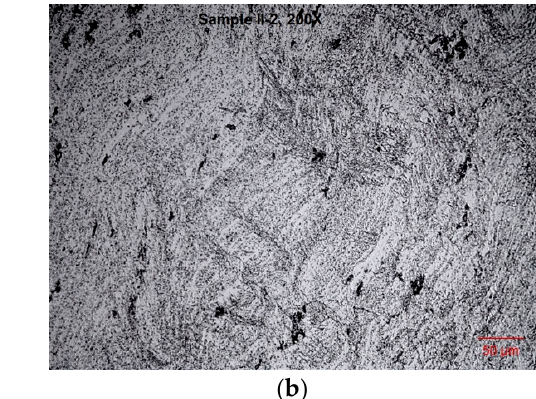
Figure 4. Optical microstructure of AA5083 after four (D) passes of sc-ECAE for ( a ) the as-received material (scale bar is 30 μ m; lamellae are oriented in the rolling/extrusion direction) and ( b ) isotropic macrostructure of the solution-treated material (scale bar is 50 μ m).